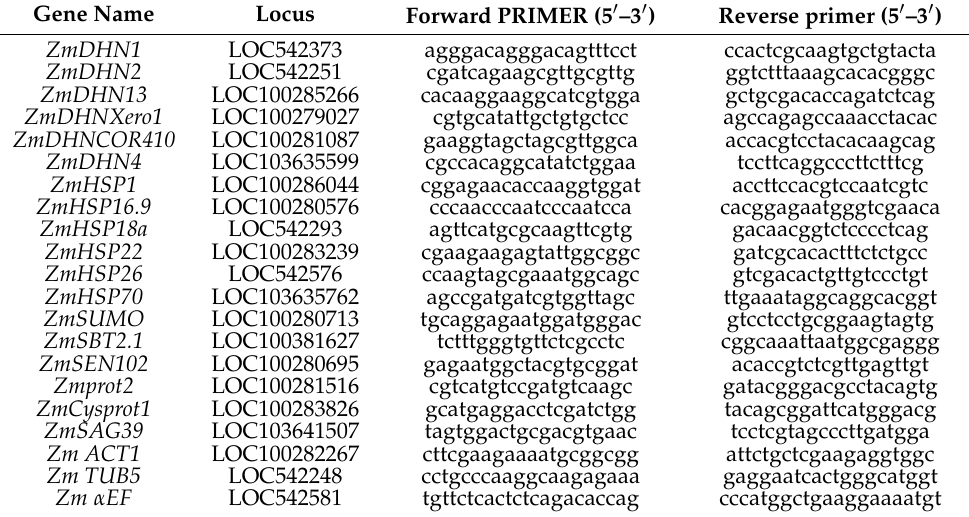
Table 1. Primer pairs used in the qRT-PCR